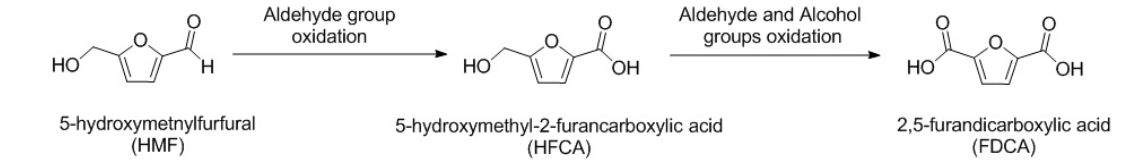
Scheme 1. Detected products from aqueous HMF oxidation over supported Au, Pd and PdAu catalysts under basic